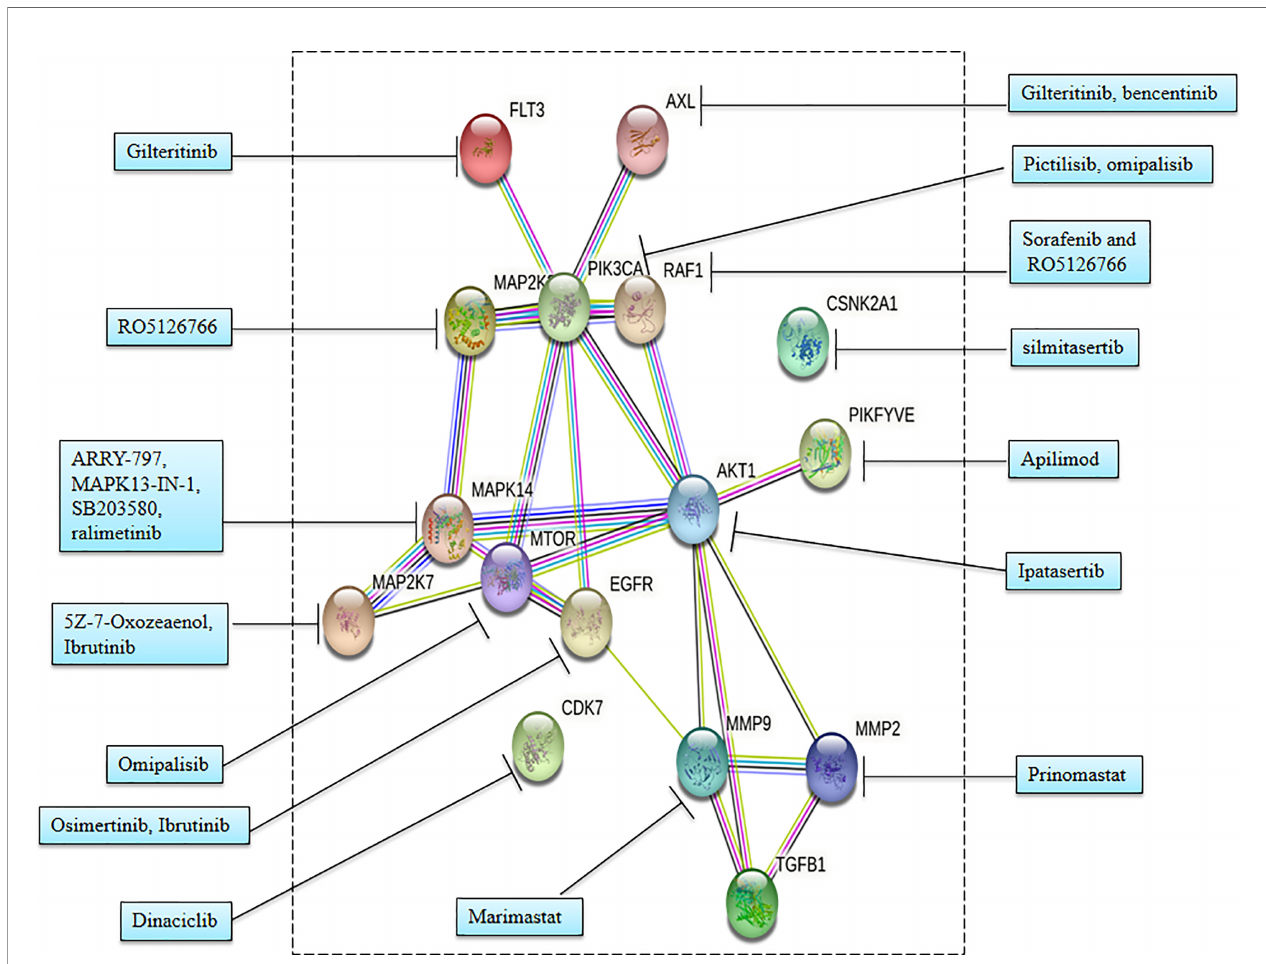
FIGURE 5 | Interaction network of therapeutic targets for COVID-19 at high con fi dence